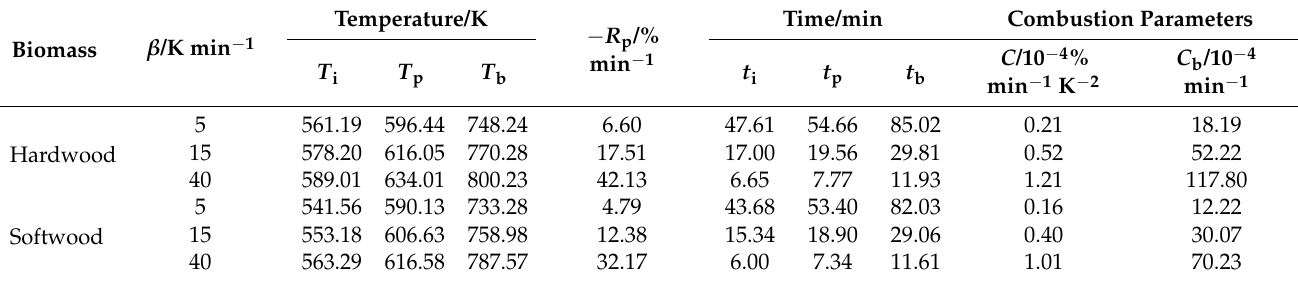
Table 8. Combustion characteristic parameters of hardwood and